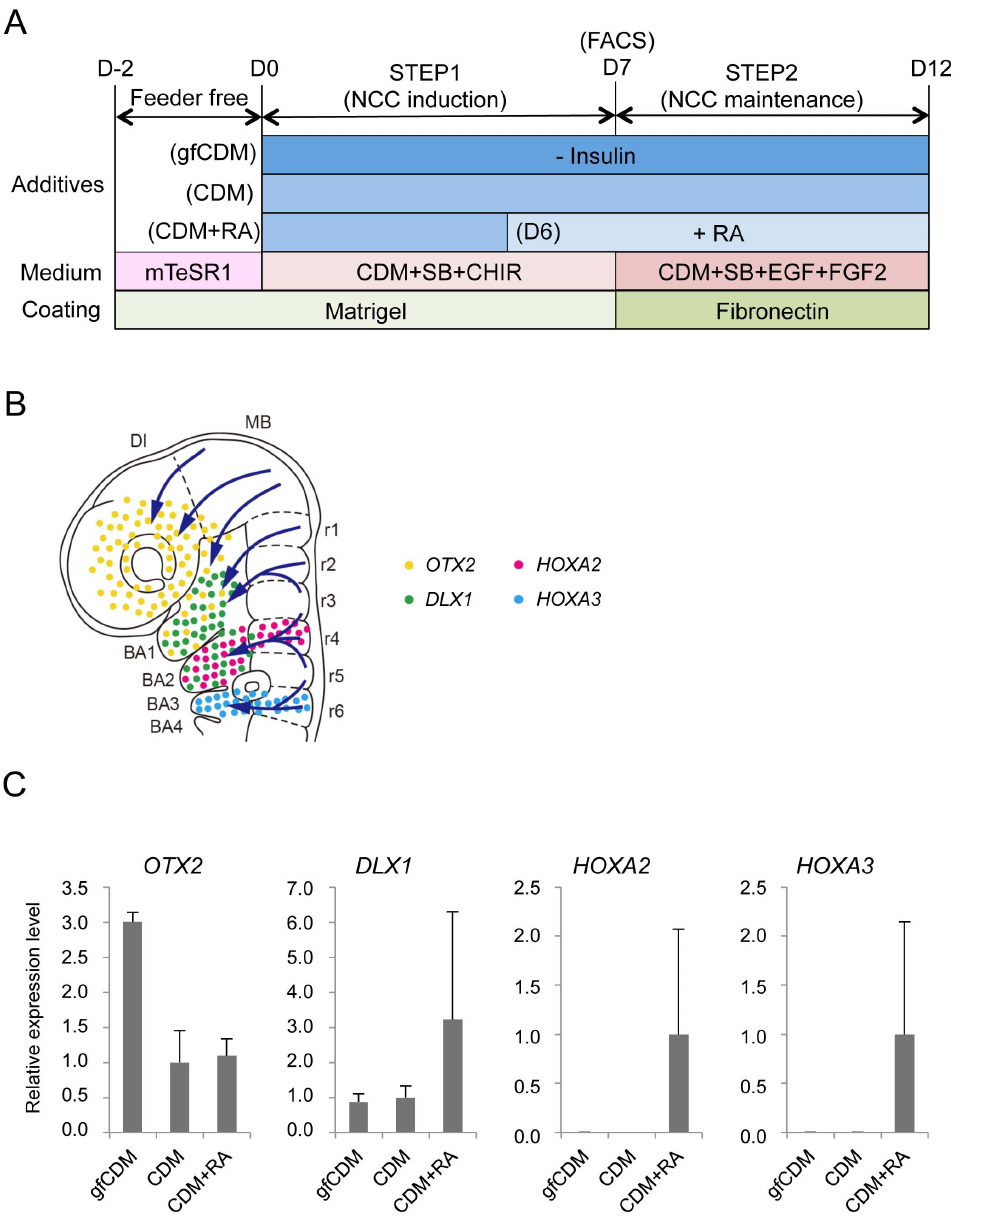
Figure 4. Modulation of regional characteristics of hNCCs. A) Schematic representation of culture conditions for the induction and maintenance of hNCCs. RA, retinoic acid (100 nM). B) Schematic distribution of marker-positive cells in the murine embryo. DI, diencephalon; MB, midbrain; BA1 to BA4, branchial arch 1 to branchial arch 4; r1 to r6; rhombomere 1 to rhombomere 6. C) The mRNA expression of regional specifier genes in hNCCs. p75 high cells were collected at the end of the hNCC induction by FACS and seeded onto fibronectin-coated dishes. RNAs were extracted when cells reached a semi- confluent state and used for RT-qPCR. The relative expression level of each gene was demonstrated using the value of cells cultured in CDM ( OTX2 and DLX1 ) or CDM + RA ( HOXA2 and HOXA3 ) as 1.0. Average ¡ SD. N 5 3, biological triplicate.